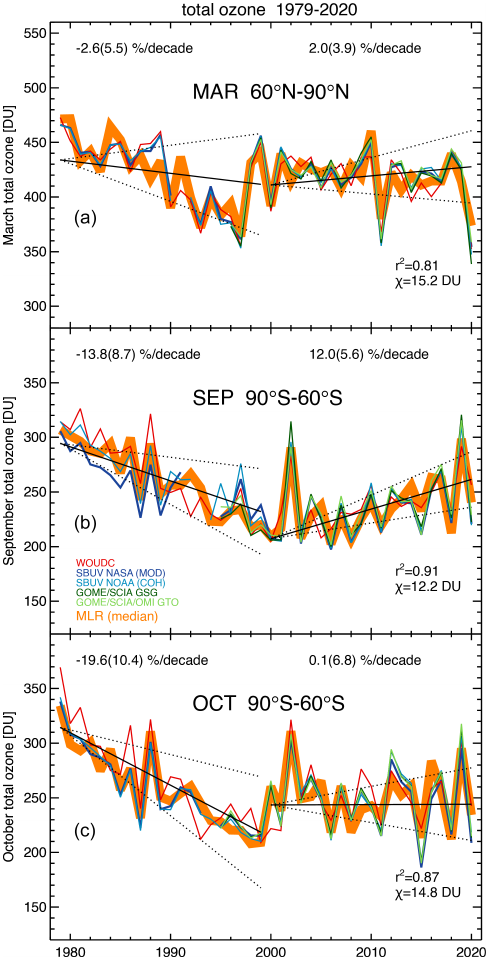
Figure 7. Polar ozone trends derived from the full MLR applied to the median time series. (a) March 60–90 ◦ N, (b) September, and (c) October 60–90 ◦ S. See Fig. 1 for more